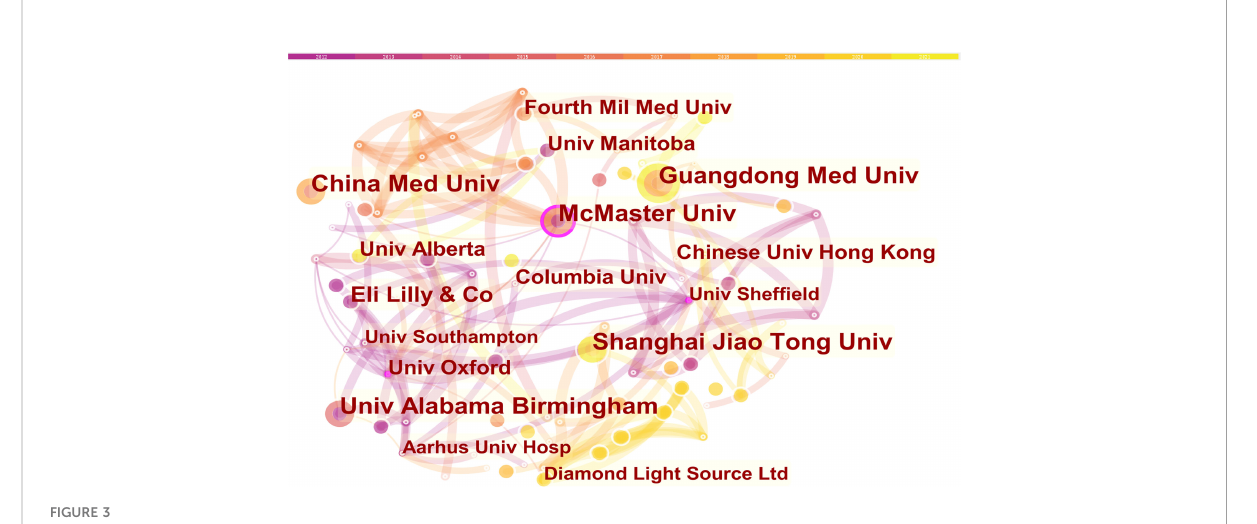
FIGURE 3 Collaboration network of